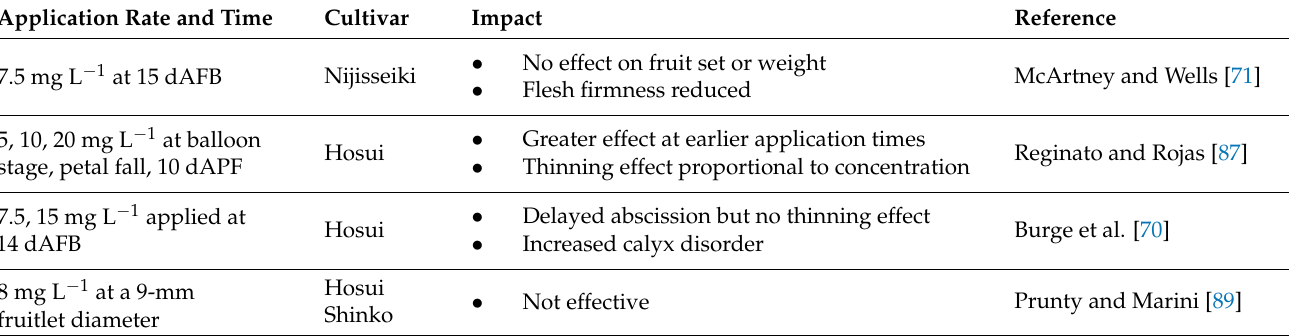
Table 9. Summary of the findings on the impact of NAA as a chemical thinning agent for